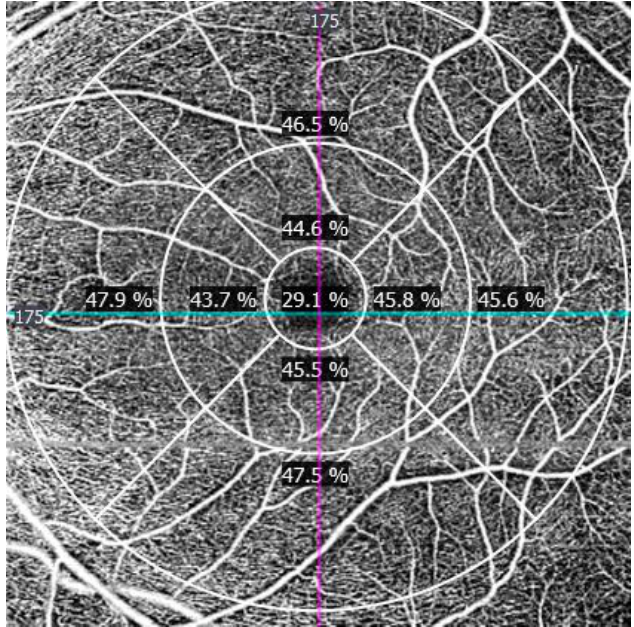
Figure 4. Perfusion density map at the macula. Units are unitless (%).